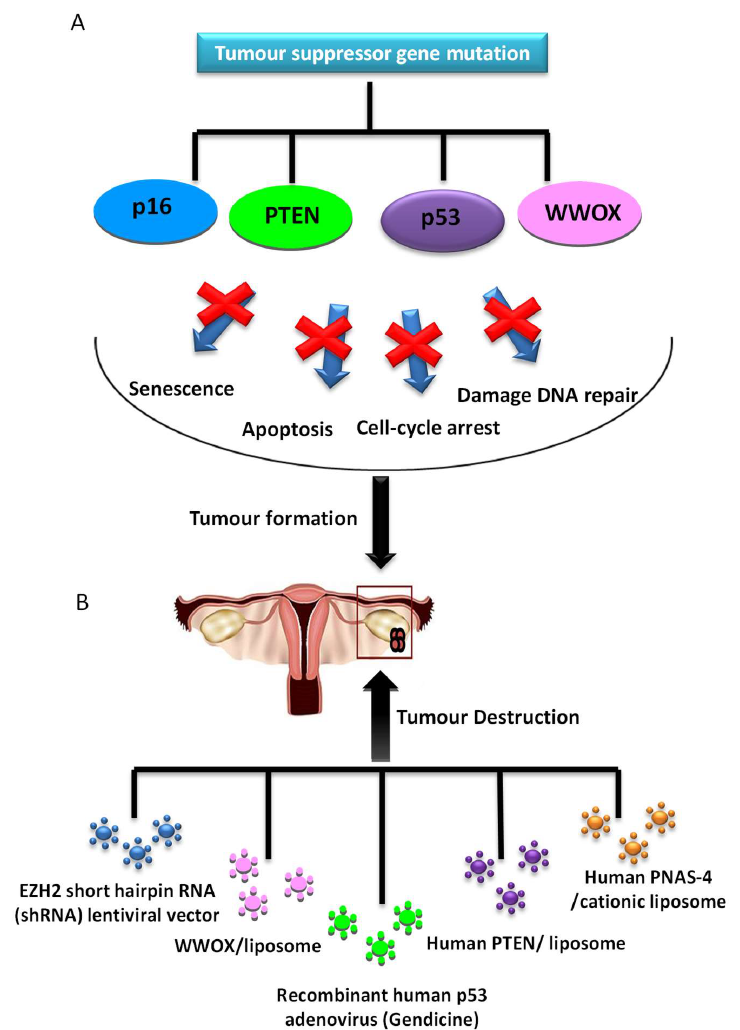
Figure 3. Tumour suppressor genes are involved in a wide variety of antitumour functions. ( A ) If these functions are inhibited, the tumour appears; ( B ) diverse strategies in gene therapy have tumour suppressor genes as a molecular target, enabling the recovery of gene function and tumour destruction.